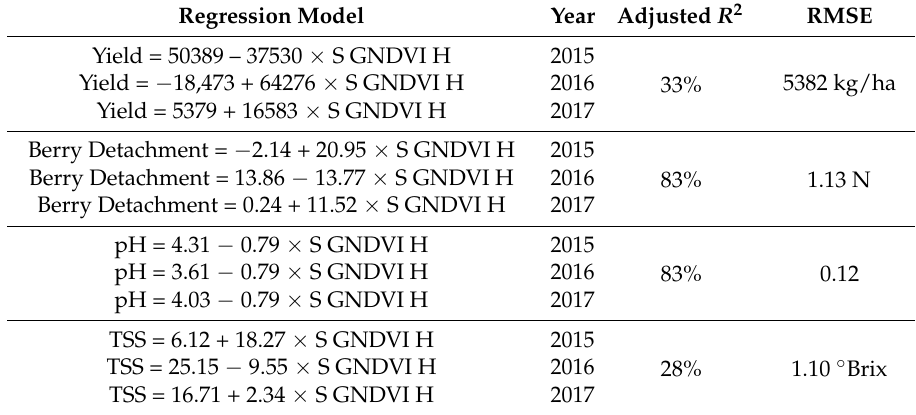
Table 8. Regression model of correlated crop parameters with satellite-derived GNDVI at the harvest crop